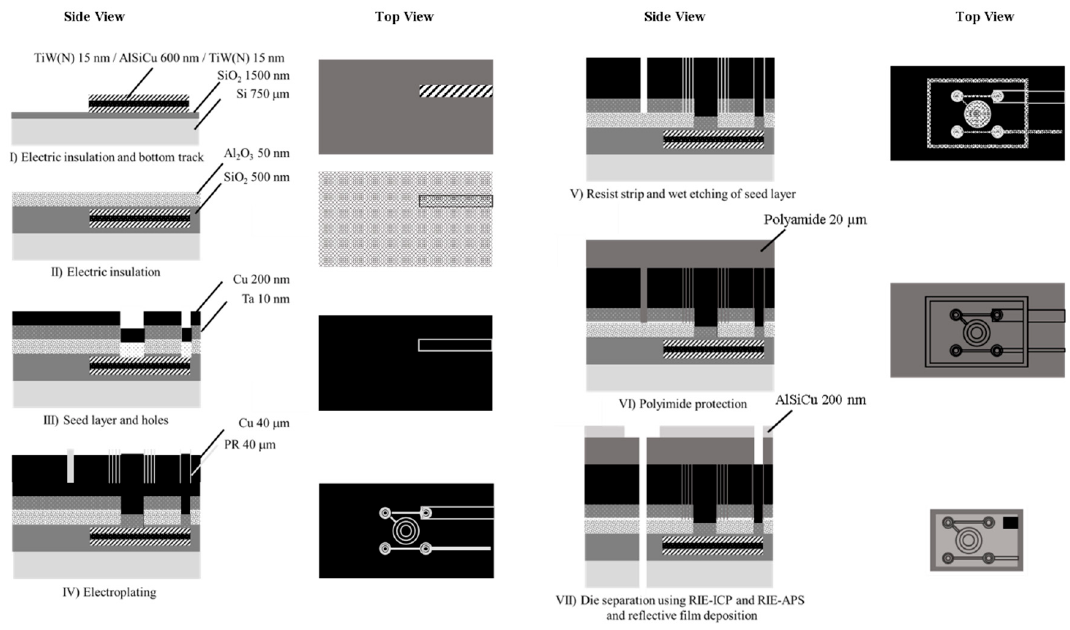
Figure 2. Process flow of the planar microelectromagnet trap (MEMT) fabricated onto the Si wafer (not to scale).